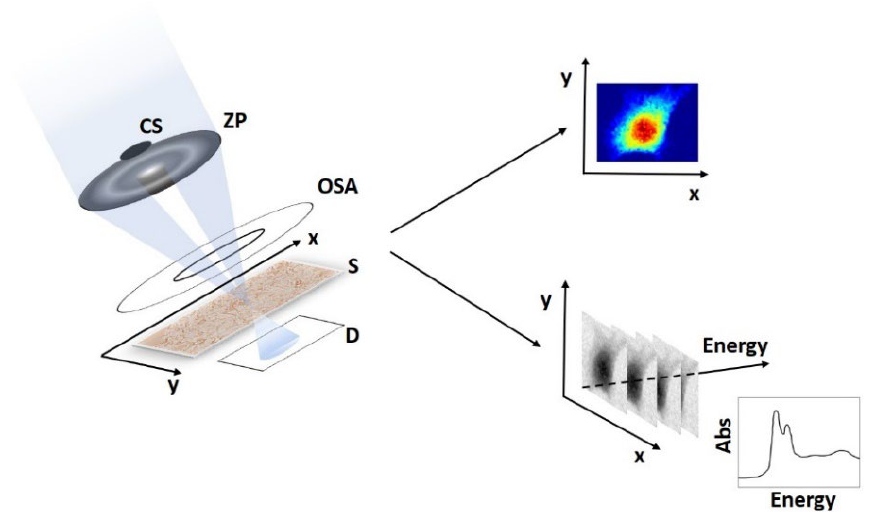
Figure 2. A sketch of combining STXM ( left ) with the two spectroscopic techniques: XRF ( top-right ) and µ -XANES ( bottom-right ). CS indicates the central stop; ZP the zone plate; OSA the diffraction order-selecting aperture; S the specimen and D the detector.